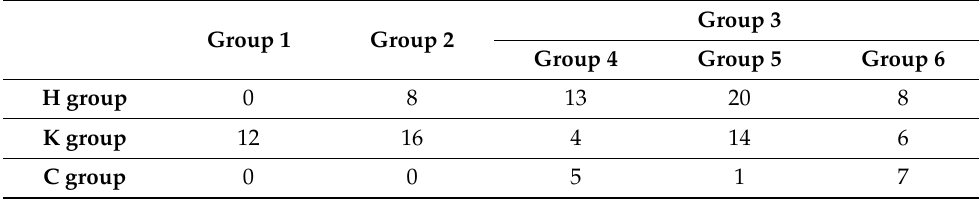
Figure 1. The tree graph from cluster analysis. The x -axis presents distance, while the y -axis includes participants of the study. Table 2. Numbers of participants from H, K, and C groups allocated to five groups created based on cluster